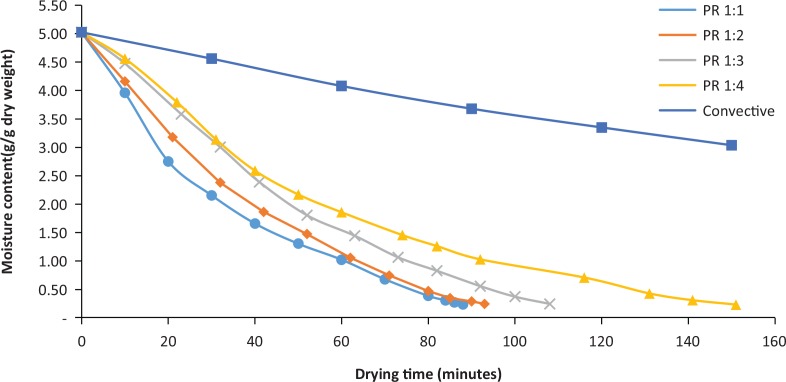
Drying curves at different drying conditions.